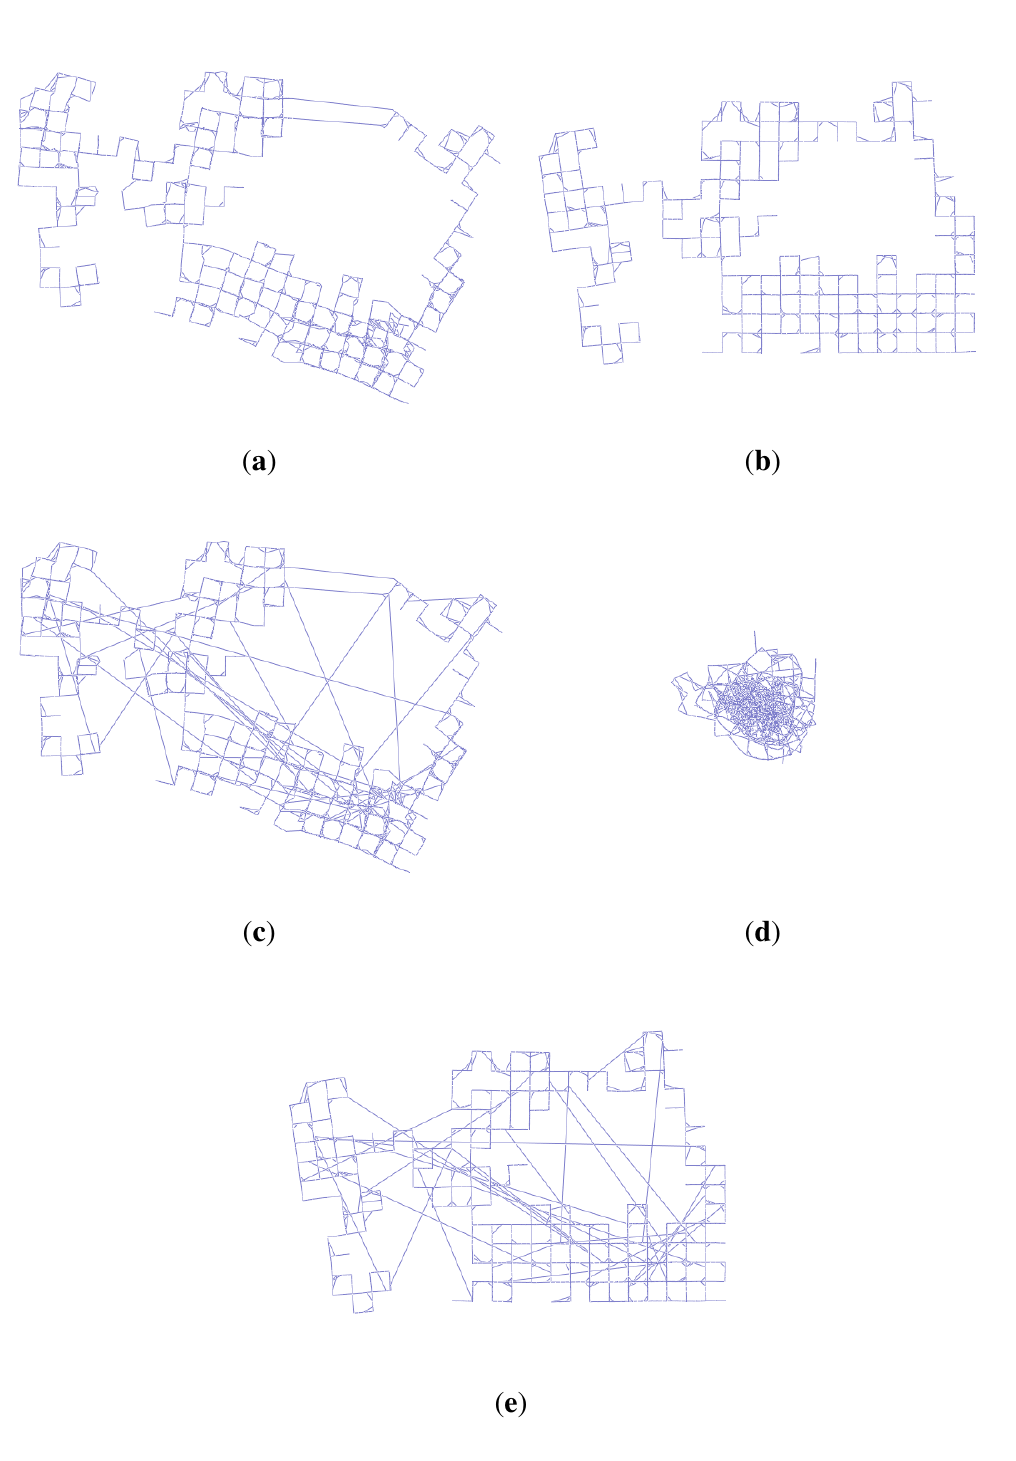
Figure 8. Example of the graph optimization with false constraint edges for the synthetic Manhattan world dataset [22]. 30 false constraints are added to the graph for evaluating different SLAM algorithms. ( a ) Before optimizing the graph with no false constraints; ( b ) Optimizing the graph with false constraints using the conventional graph SLAM; ( c ) Before optimizing the graph with false constraints; ( d ) Optimizing the graph with false constraints using the conventional graph SLAM; ( e ) Optimizing the graph with false constraints using the dynamic covariance scaling (DCS)-based graph SLAM